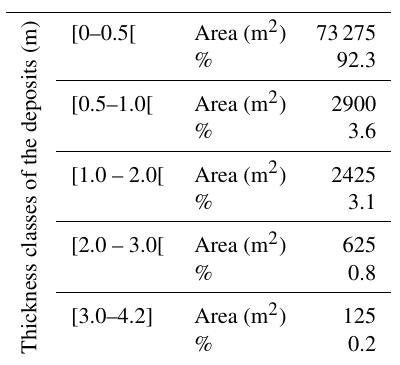
Table 9. Classification of the deposits thickness and occupied area (Scenario